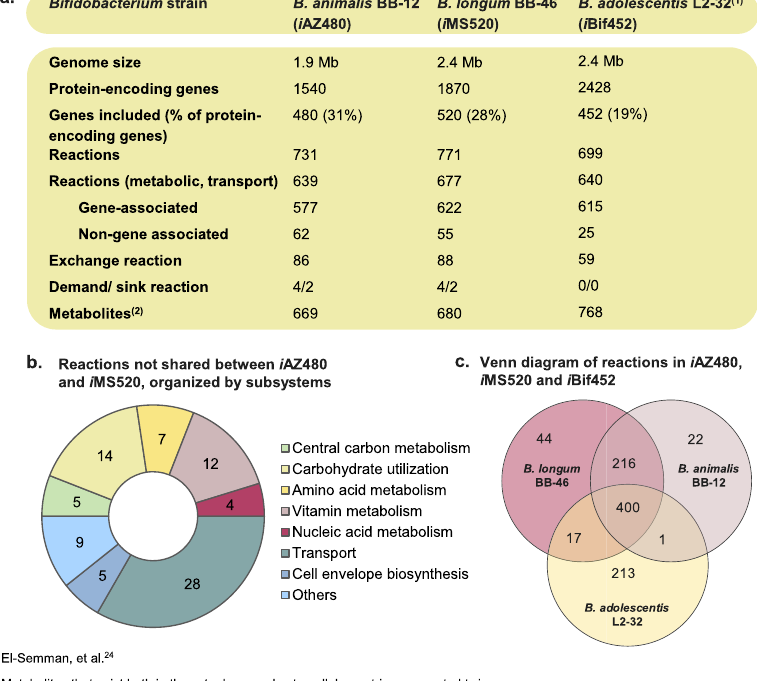
Characteristics of BB-12 and BB-46 genome-scale metabolic models